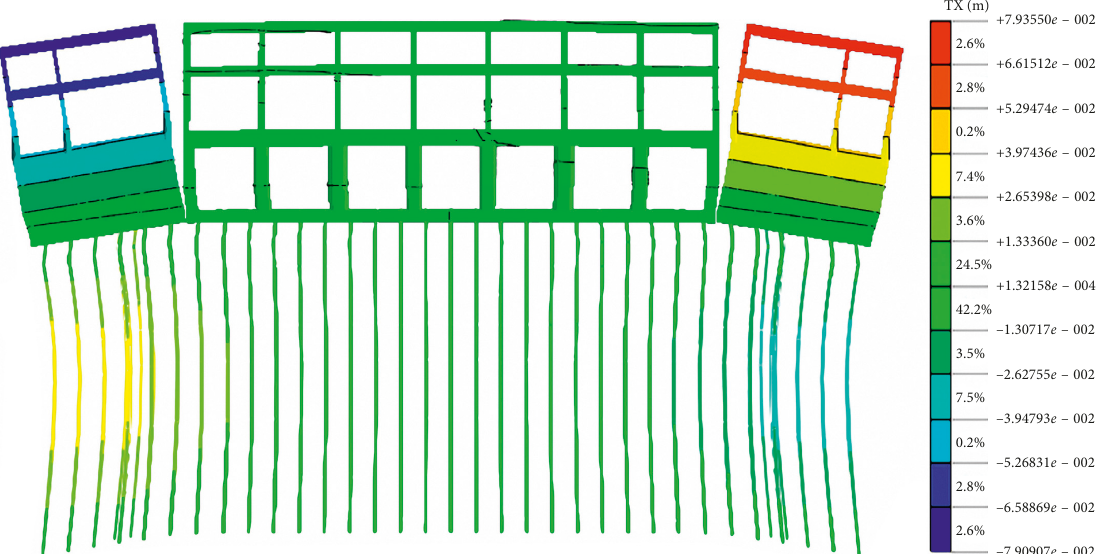
Figure 17: Magnified deformation of the sluice structure and pile (consolidation degree is 0).